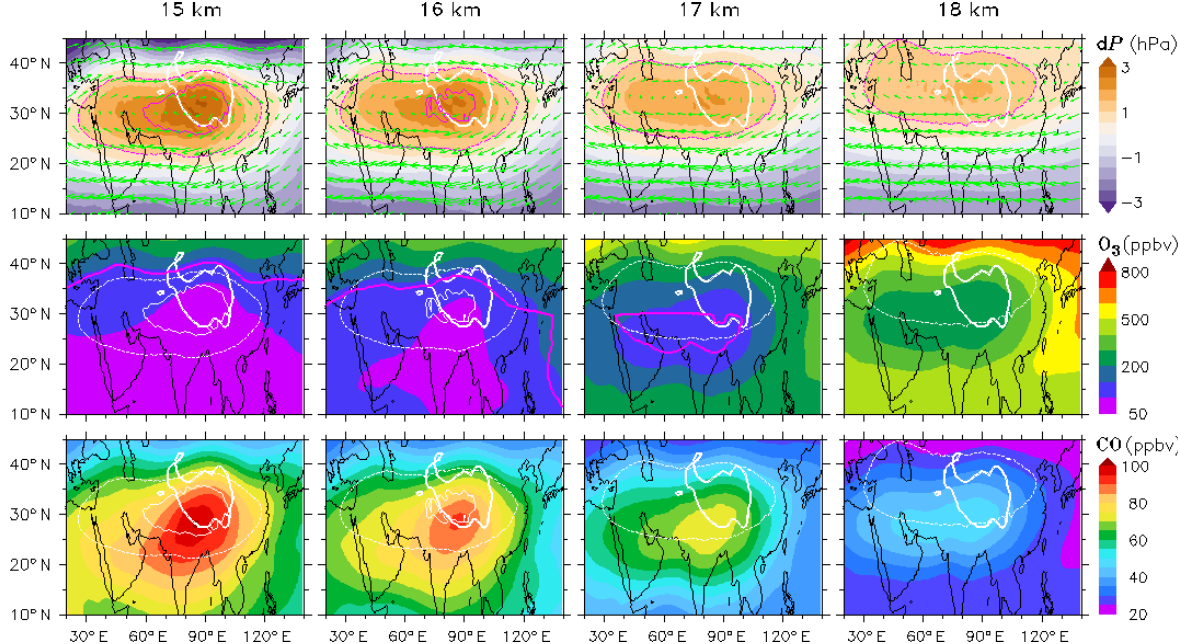
Figure 2. Pressure deviation, d P , in units of hPa (top), O 3 in units of nmolmol − 1 or ppbv (middle), and CO in units of nmolmol − 1 or ppbv (bottom) at altitudes of 15, 16, 17, and 18kma.s.l. (first to fourth columns), averaged for July–August 2010, 2011, and 2012, from EMAC simulations. Pressure deviation, i.e., d P = P − P avg , refers to the difference of pressure, P , at each model grid relative to the regionally averaged value, P avg , at the same altitude, with P avg values of 132.1, 111.4, 93.6, and 78.7hPa at 15, 16, 17, and 18km altitudes, respectively. Green arrows indicate the wind field (top) and purple solid lines the position of the WMO tropopause (middle). Purple (top) and white (middle and bottom) thin dashed lines (and also solid lines) are the pressure deviation contour of 1hPa (and 1.3hPa), highlighting the anticyclone area (and its core area, applicable to the 15km panels). Thick white lines refer to the terrain height contour of 3km, highlighting the Tibetan Plateau area.